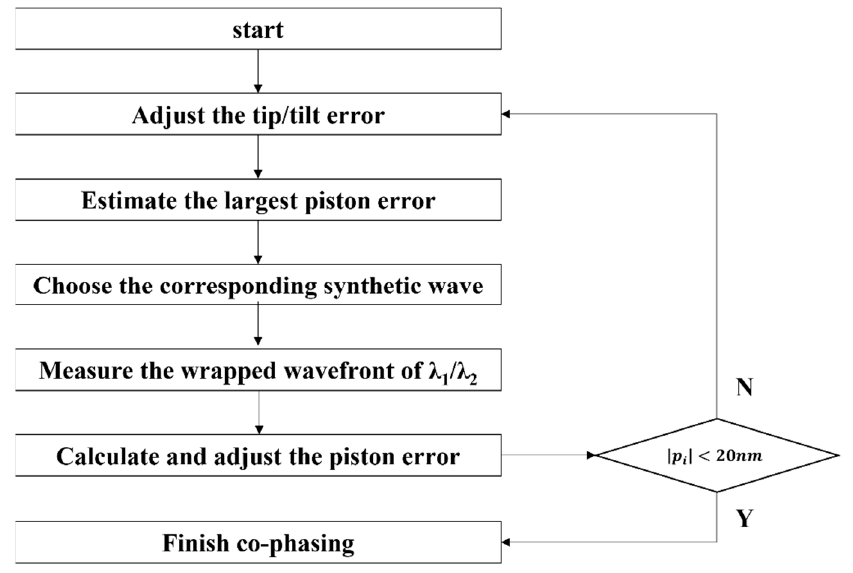
Figure 7. Flowchart of the experiment.